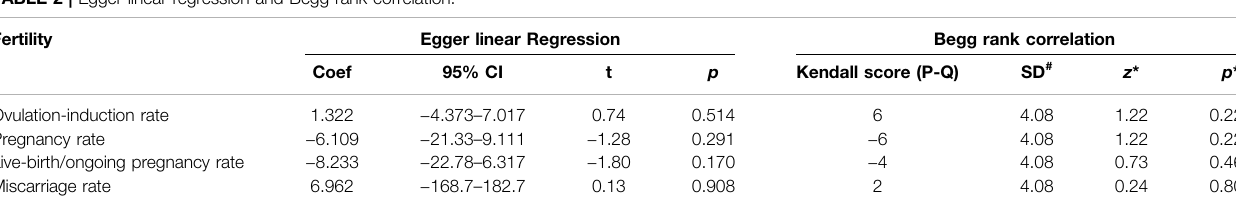
TABLE 2 | Egger linear regression and Begg rank correlation. Fertility Egger linear Regression Begg rank correlation Coef 95% CI t p Kendall score (P-Q) SD # p * Ovulation-induction